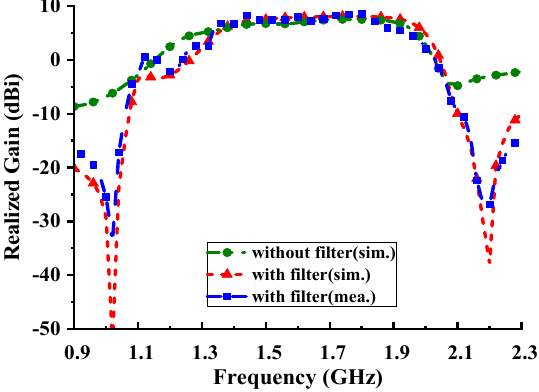
Figure 8. Simulated and measured realized gain. Figure 9a–c depicts the simulated and measured radiation patterns of the prototype in the xz and yz planes at 1.5, 1.74, and 2 GHz, respectively. The measured results agree well with the simulation results. It is observed that radiation patterns of the antenna remain stable throughout the frequency band.